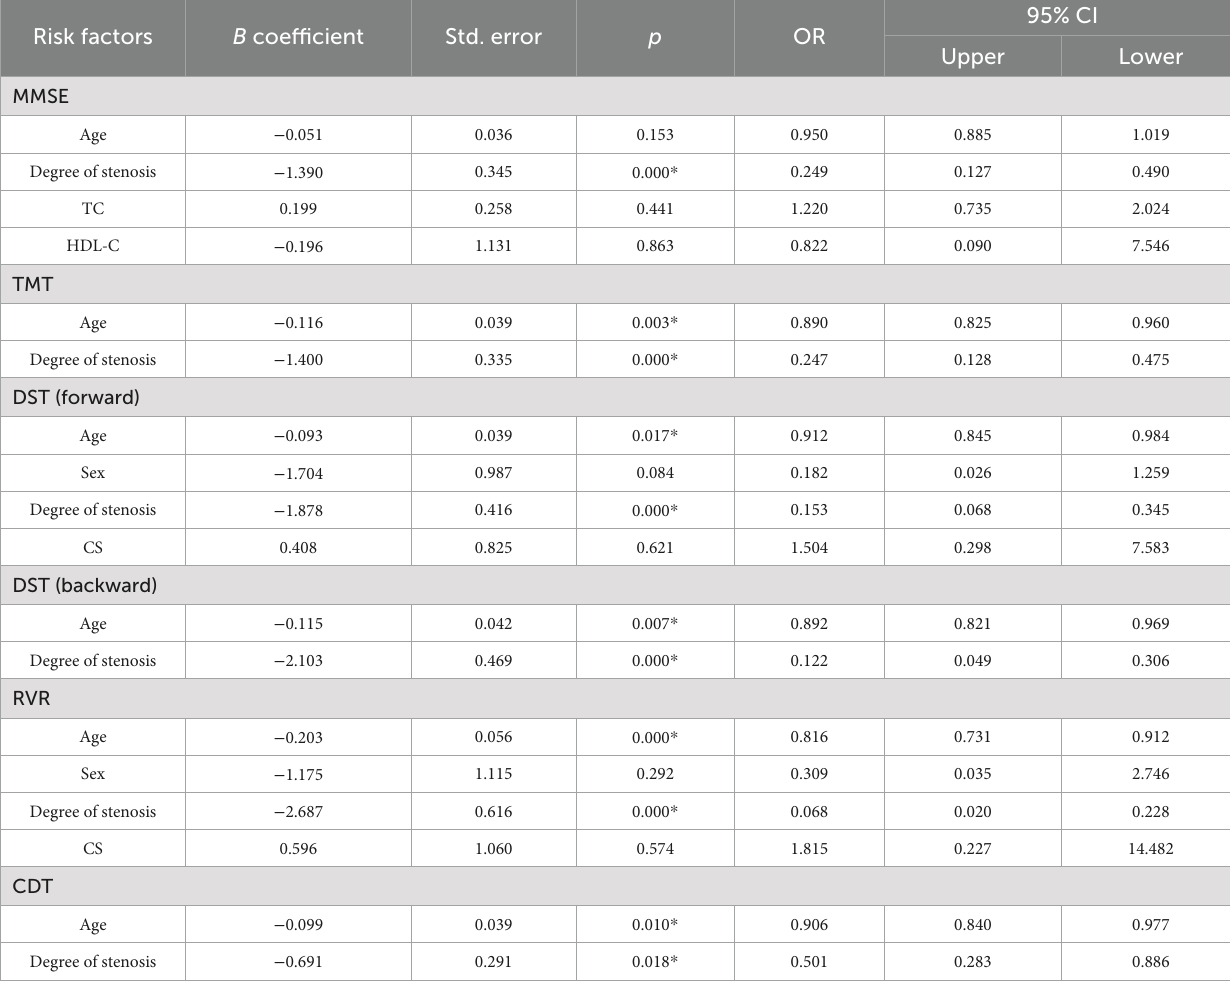
TABLE 6 Multiple logistic regression analysis for risk factors of cognitive impairment in patients with right carotid artery stenosis.